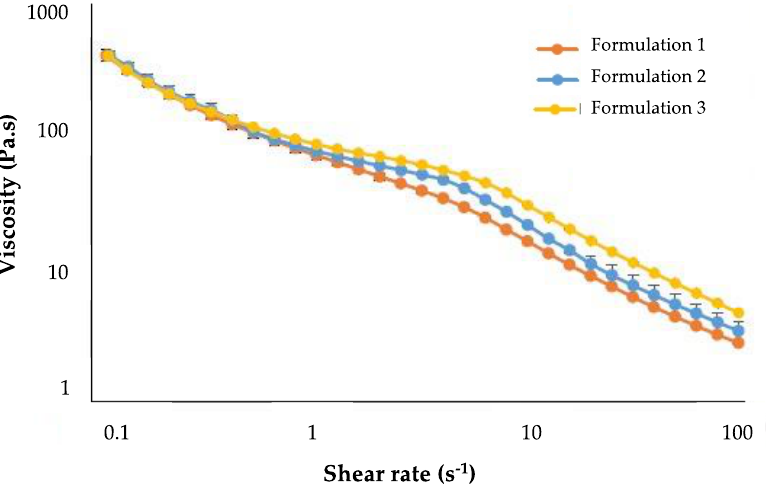
Figure 2. Graphic that represents the variation of shear viscosity (Pa.s) with shear rate (s − 1 ) for the 3 base formulations (mean ± standard deviation, n = 3).